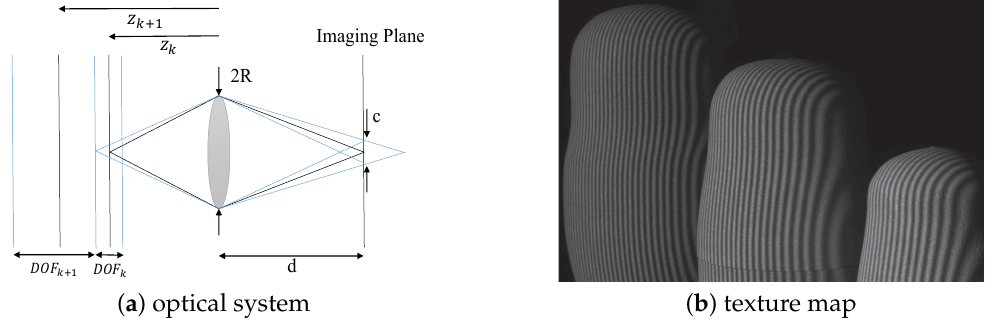
Figure 2. Optimal focus positions and texture map extraction. ( a ): optical system; ( b ): texture map. The optimal sequence of focus positions has no gaps or overlaps between depths of field (DOFs) from consecutive focal planes. The image projected by the finest stripes of the gray code sequence is extracted into the focal